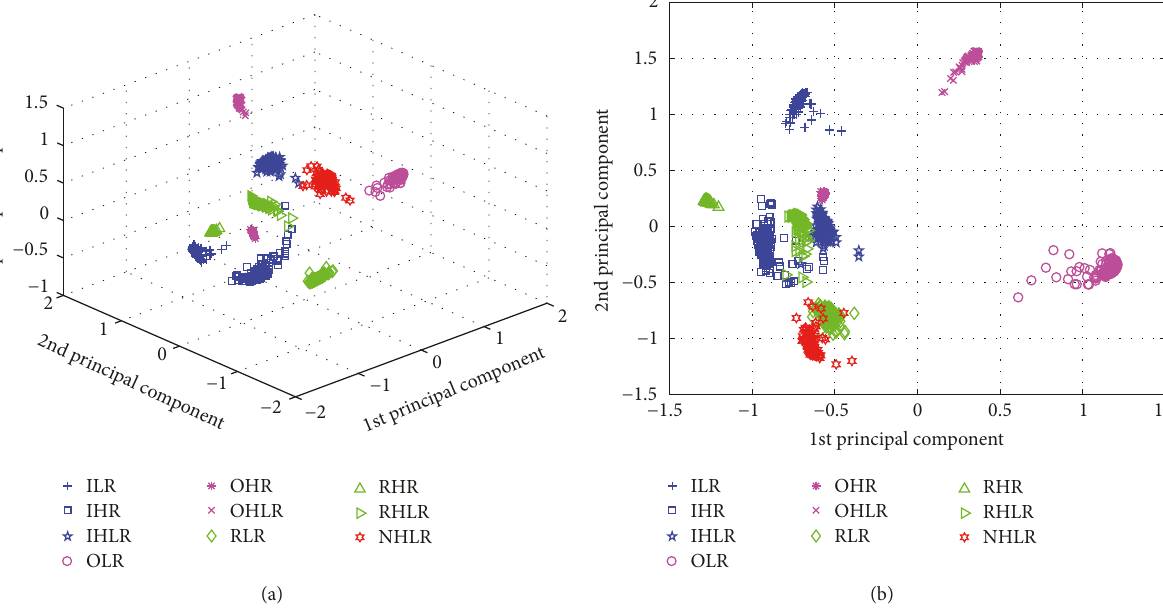
into three major steps. Firstly, kernel function is employed to enhance the feature learning capability, and a new AE is designed termed kernel AE (KAE). Subsequently, a deep neural network is constructed with one KAE and multiple AEs to extract inherent features layer by layer. Finally, softmax is adopted as the classifier to accurately identify different bearing faults, and error backpropagation algorithm is used to fine-tune the model